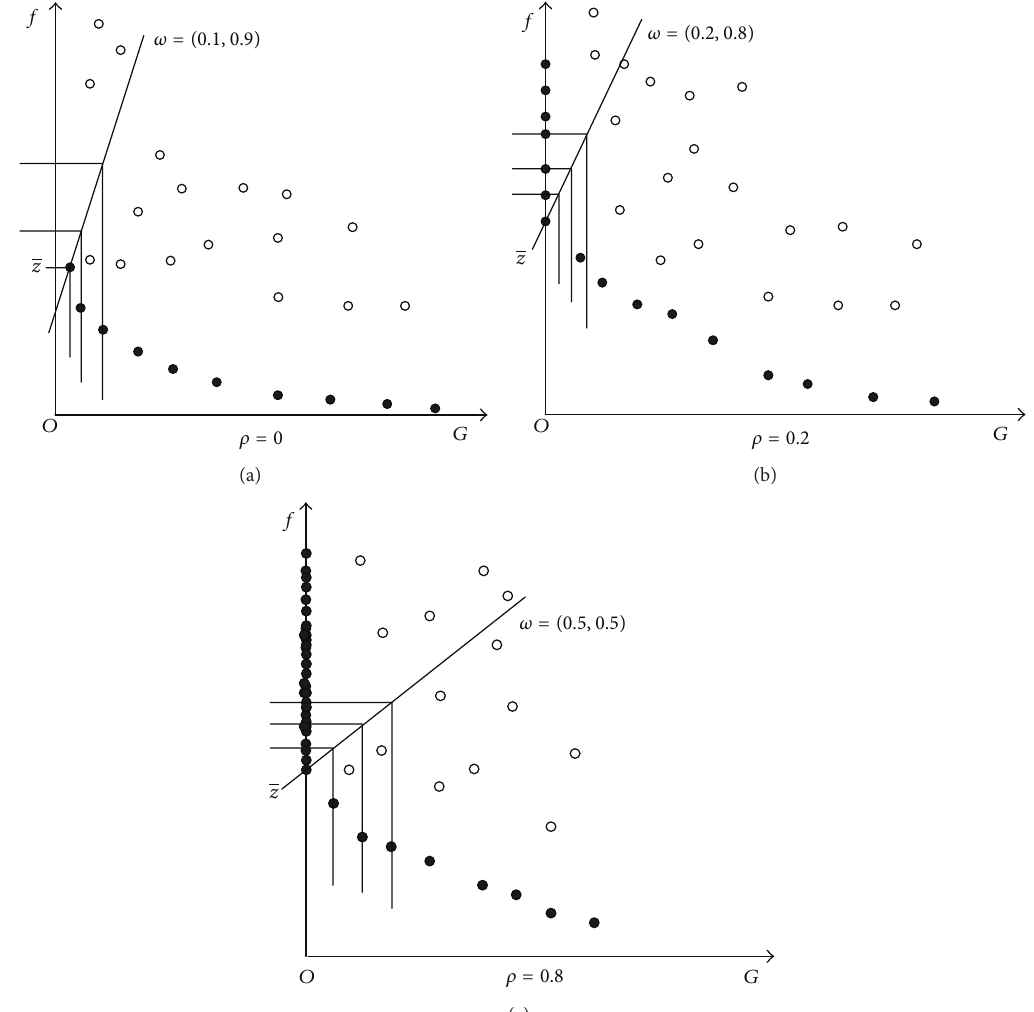
Figure 3: Contours of the fitness function in different stages and the